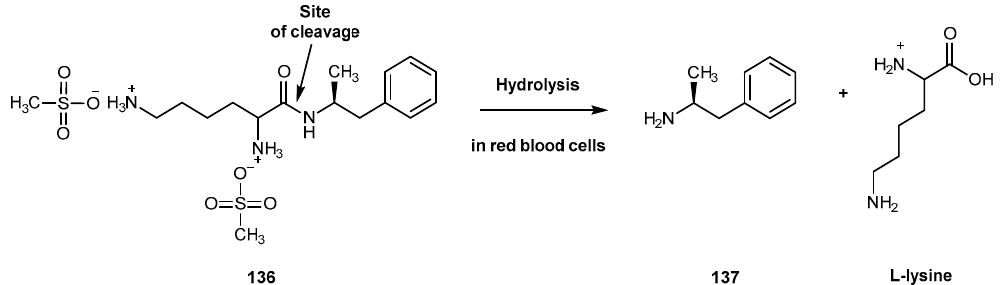
Figure 55. The enzymatic conversation of LDX ( 136 ) to active D -amphetamine ( 137 ) (adapted from [182]).